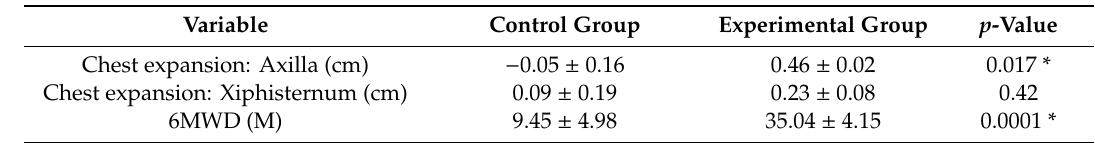
Table 4. Comparison of mean di ff erence in pre and post intervention chest expansion and 6MWD between the control and experimental groups: mean ±